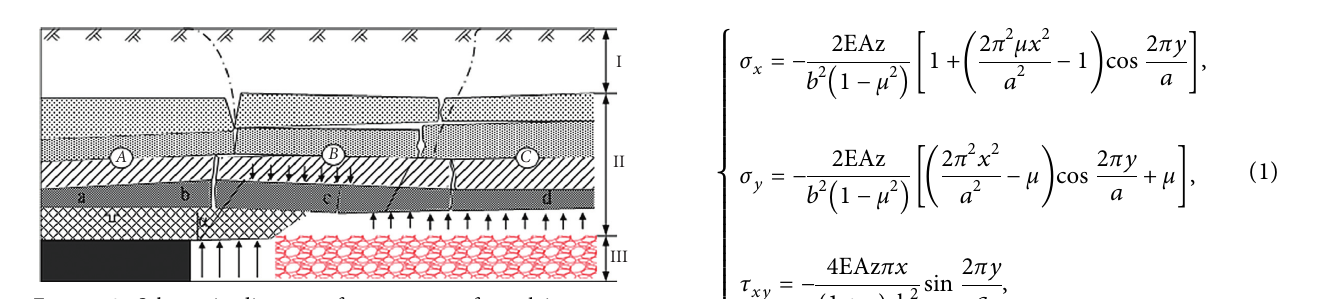
Figure 3: Schematic diagram of movement of overlying strata above the traditional fully mechanized mining face. A: zone affected by support of coal wall; B: bed-separation zone; C: recompacted zone; α represents the angle affected by support; I, II, and III indicate the bending and subsidence zone, the fracture zone, and the caving zone, respectively.